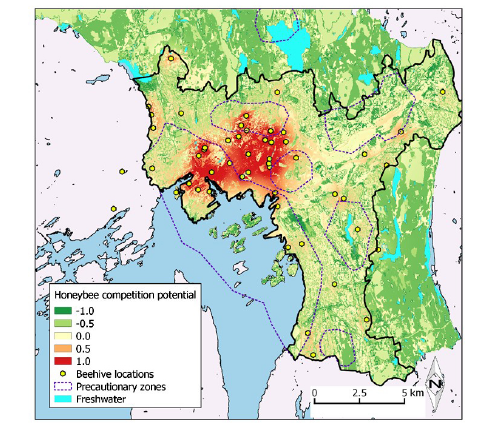
Fig. 4. Map of the relative resource demand of foraging honeybees, accounting for the floral resource availability of the Oslo municipality landscape. Precautionary zones represent areas proposed by Oslo Urban Environmental Agency to protect potentially sensitive populations of red-listed wild bee species from competing with domestic